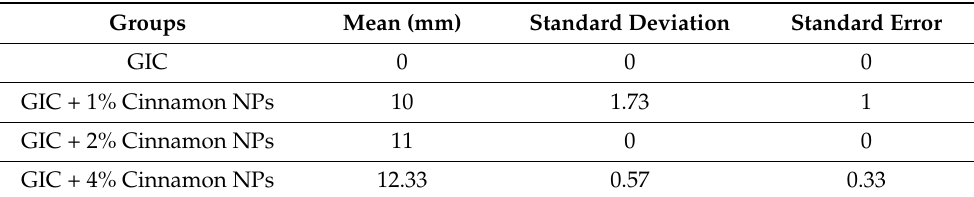
Table 1. Diameter of inhibition zone of S. mutans bacteria for GIC in in different weight percentages of cinnamon NPs.